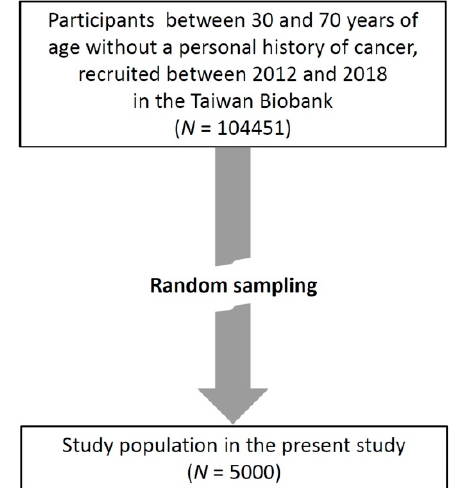
Figure 1. Flowchart of study population.